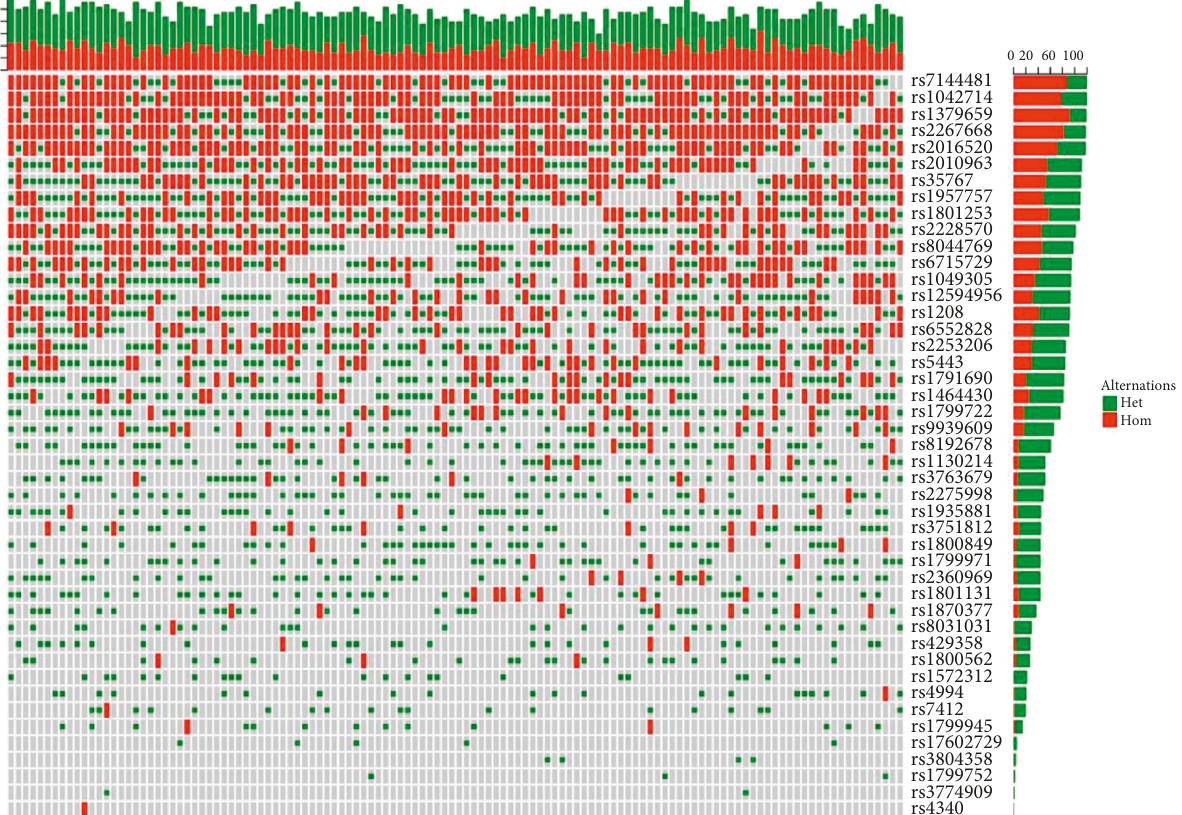
Figure 2: Panorama of 45 SNP gene mutations in